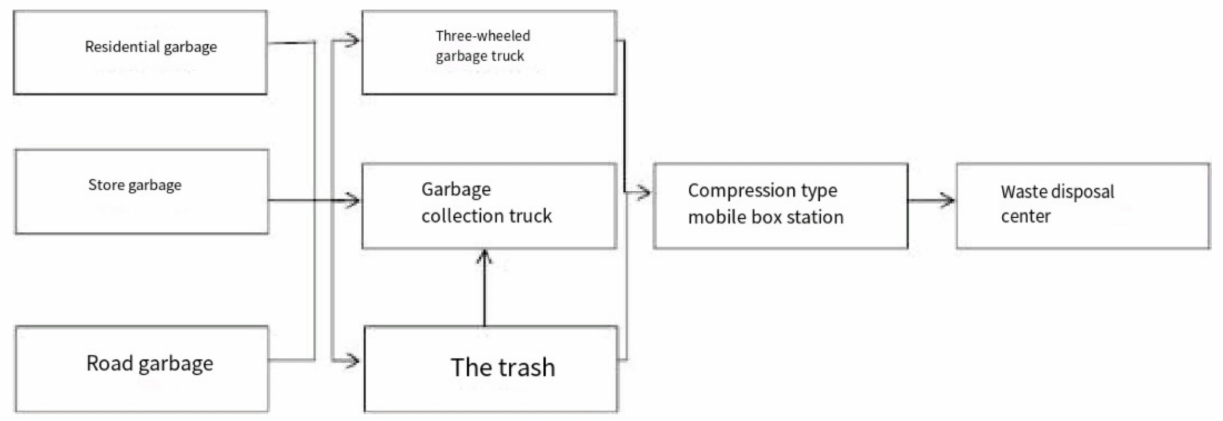
Figure 5. Flow chart of the garbage collection and transfer